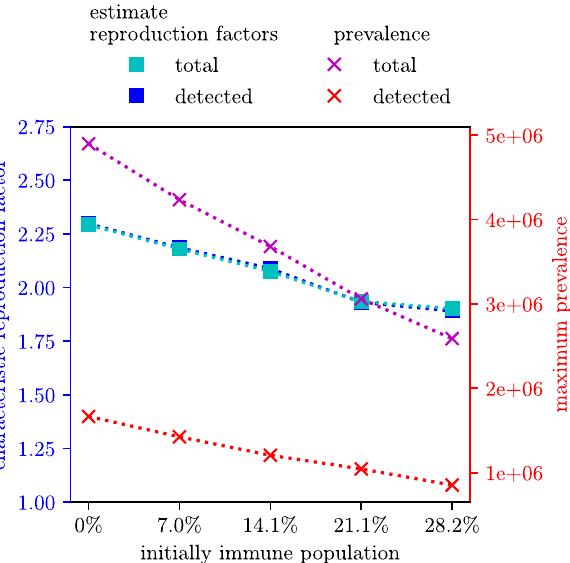
Figure 9. Effective reproduction number and maximal prevalence as a function of initial immunization level for the results of the agent-based simulation.